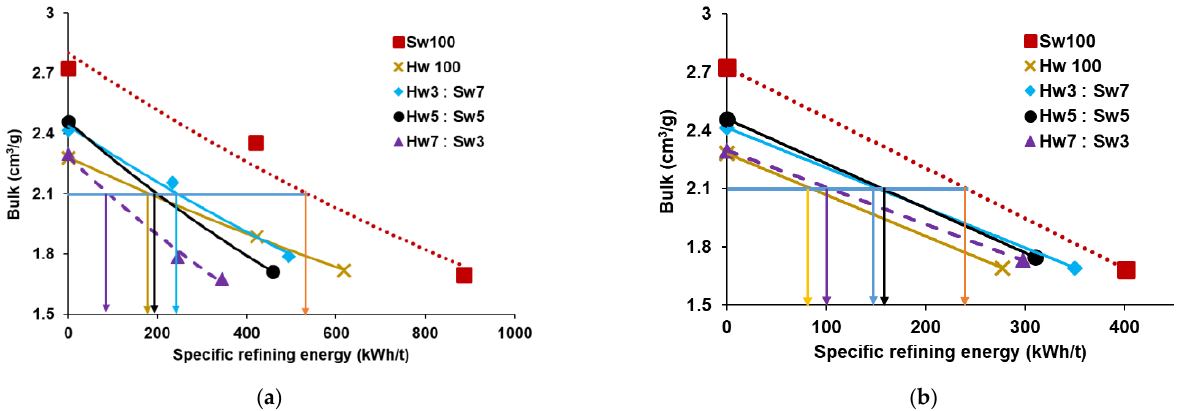
Figure 10. Effect of CEL on bulk of paper made of the mixed pulps: ( a ) PA55; ( b ) PB97.